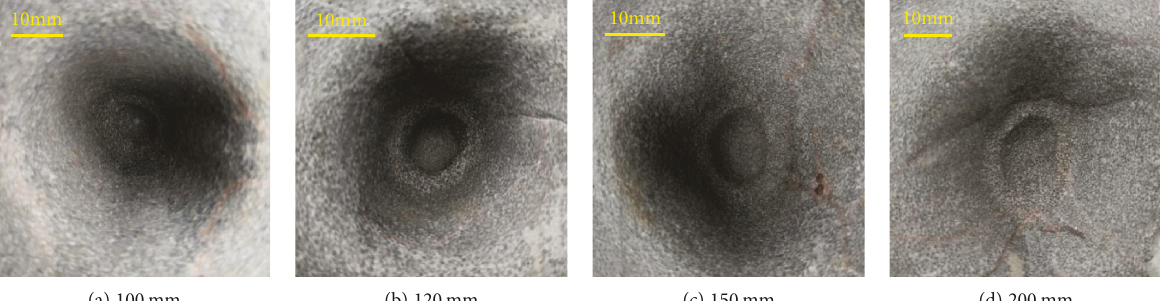
Figure 4: Features of the erosion pit at various stando ff distances.